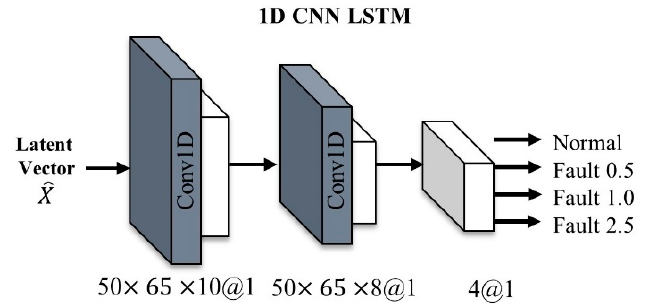
Figure 8. The classifier based on 1D CNN LSTM.